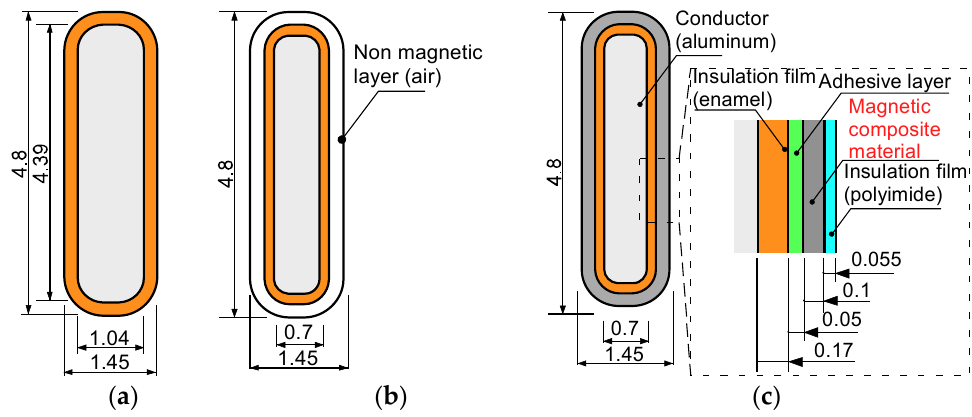
Figure 3. Winding structures (unit: mm): ( a ) rectangular winding; ( b ) thin rectangular winding; ( c ) magnetic tape winding.